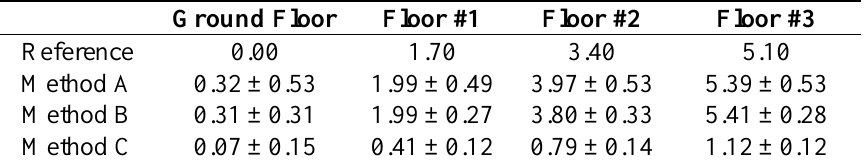
Table 5. Mean value ± SD of the pressure altitude, expressed in meters. Statistics computed using signal plateaus for each floor, including ground floor ( stair-walking